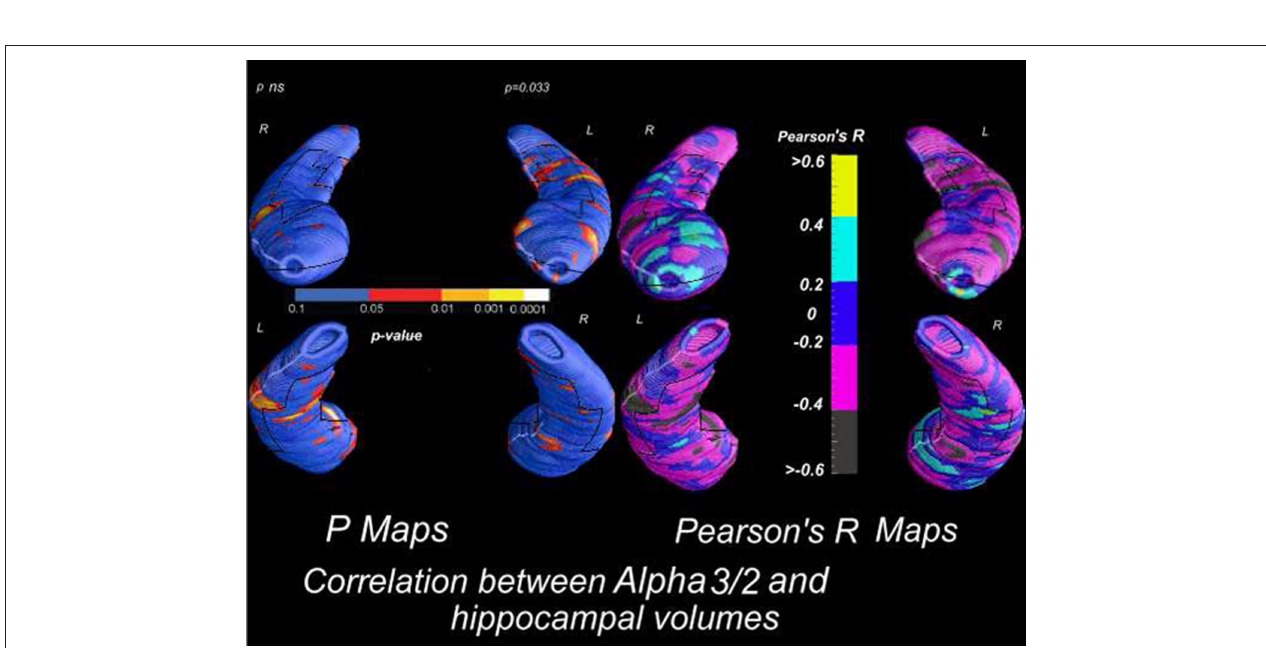
FiGurE 7 | Correlation between alpha3/alpha2 power rhythm ratio and volumes of hippocampal subregions in AD patients.